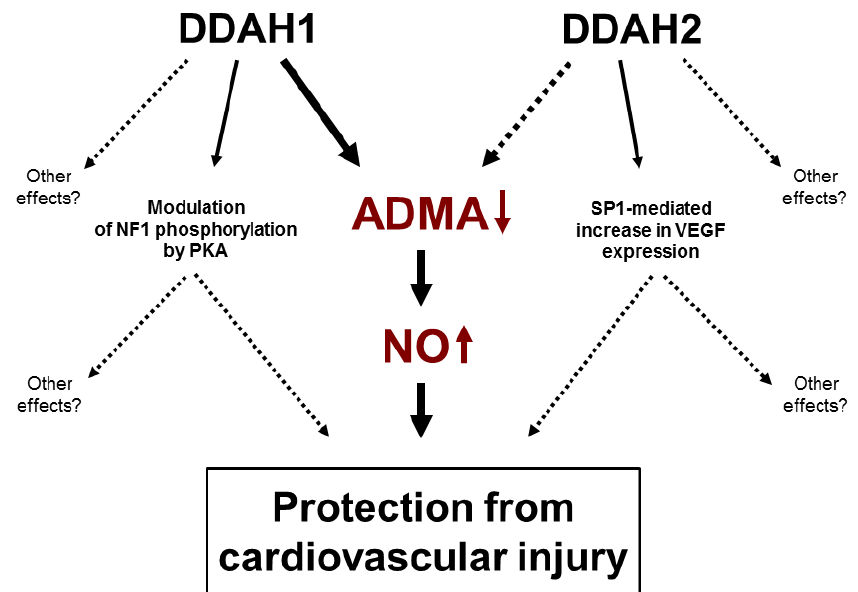
Figure 2. Protective effects of DDAHs . Solid lines—proven effects. Dashed lines—hypothesized effects. DDAH1 lowers ADMA, which leads to elevation in NO bioavailability and protects from cardiovascular injury. The relative contribution of DDAH2 to ADMA clearance is still not entirely clear. Both DDAH1 and DDAH2 have been shown to have ADMA-independent effects.